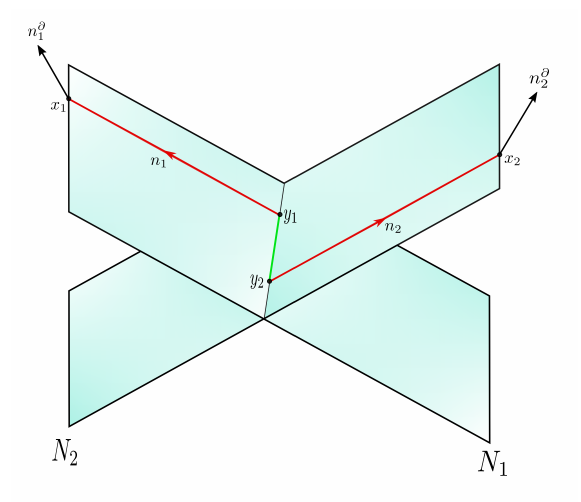
Figure 6: Bulk setup for computing two-point correlator of twist fields with non- zero spin. There are boundary normal vectors n ∂ the asymptotic boundary. The black points are on the null curves descending from these boundary points and they are equipped with normal vectors n modified from [ 60 ]